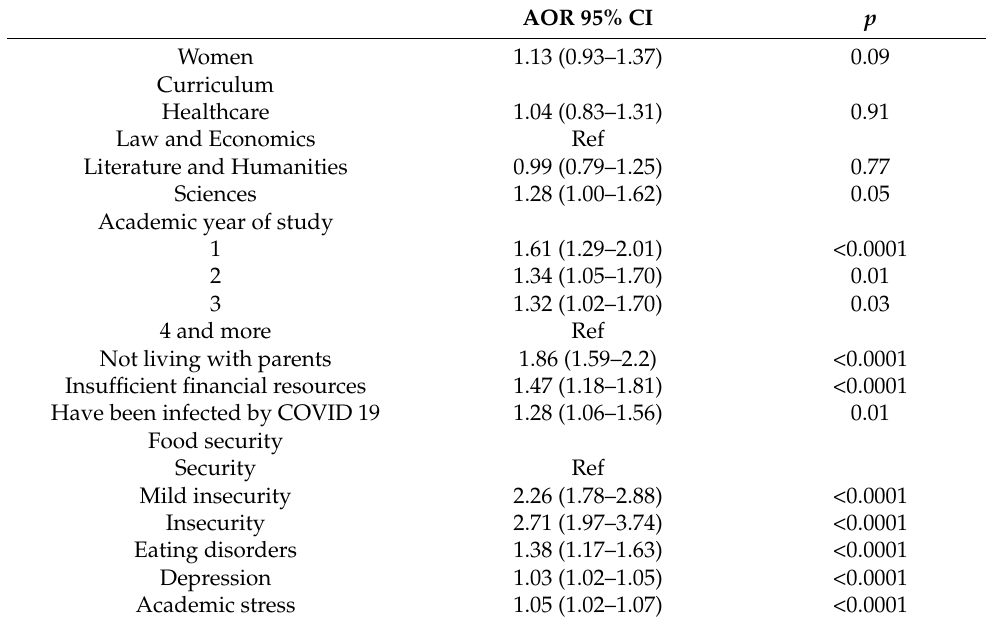
Table 3. Factors associated with the decrease in the PNNS-GS2; logistic regression ( n =